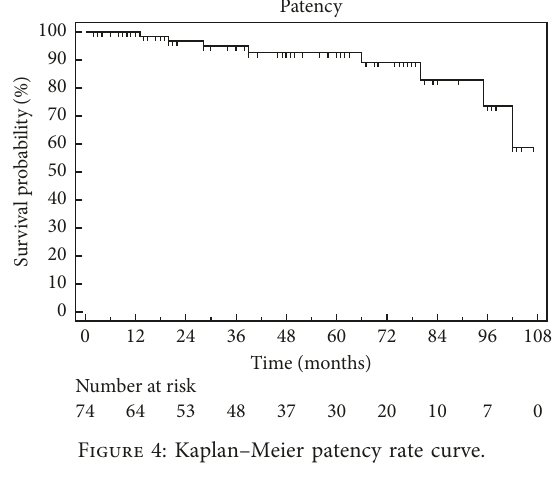
Figure 4: Kaplan–Meier patency rate curve.